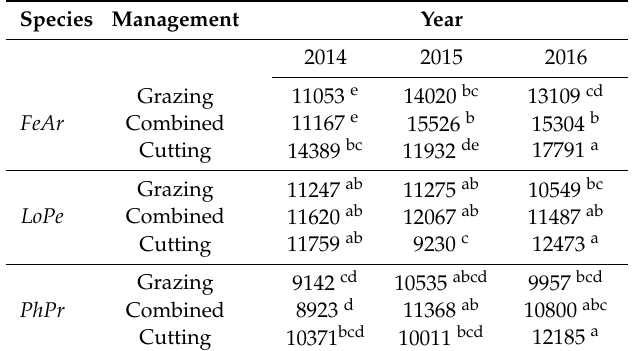
Table 5. Dry matter yields (Lsmeans, in kg DM ha − 1 ) of the mixtures with the main species Festuca arundinacea ( FeAr ), Lolium perenne ( LoPe ), and Phleum pratense ( PhPr ) for di ff erent years and management regimes as averaged over the three